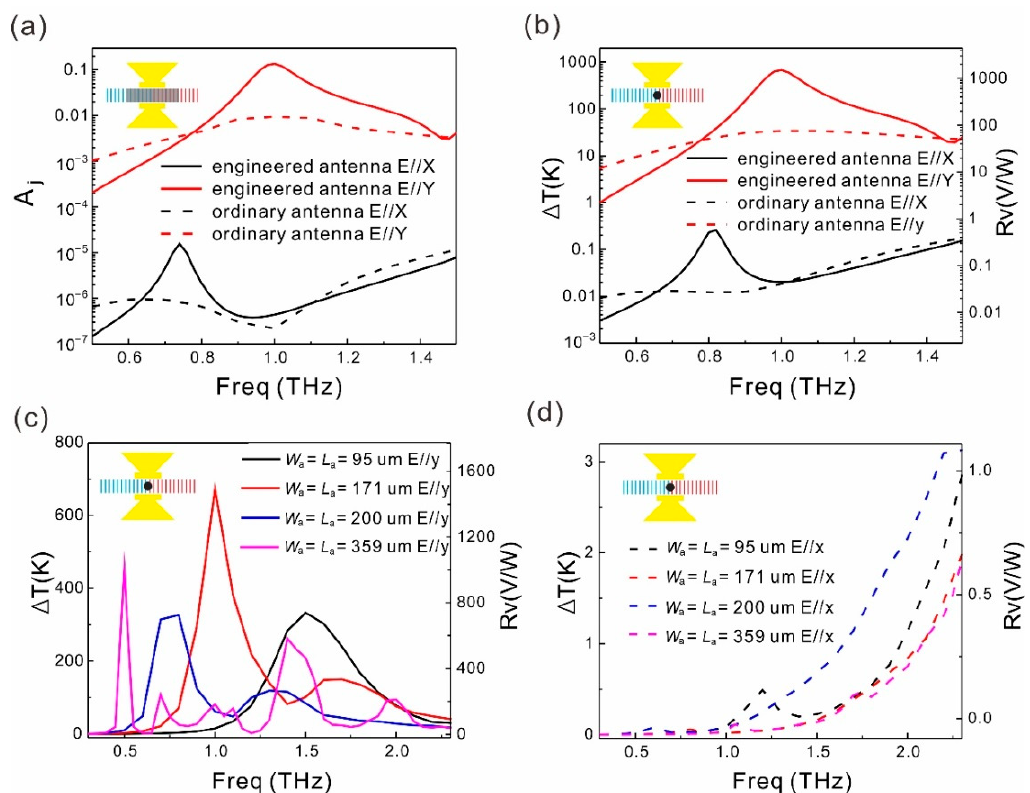
Figure 5. ( a ) Spectra of A j of the ordinary antenna integrated SWCNT film and that of the engineered antenna integrated SWCNT film for x - and y -polarized incident light at 1 THz. ( b ) Spectra of ∆ T and R V of the ordinary antenna integrated SWCNT film and the engineered antenna integrated SWCNT film for x - and y -polarized incident light at 1 THz. ( c , d ) Spectra of ∆ T and R V of the engineered antenna integrated SWCNT film for four different antenna sizes ( L a = W a = 95 µ m, 150 µ m, 200 µ m, 379 µ m) excited by y - and x -polarized light, respectively.